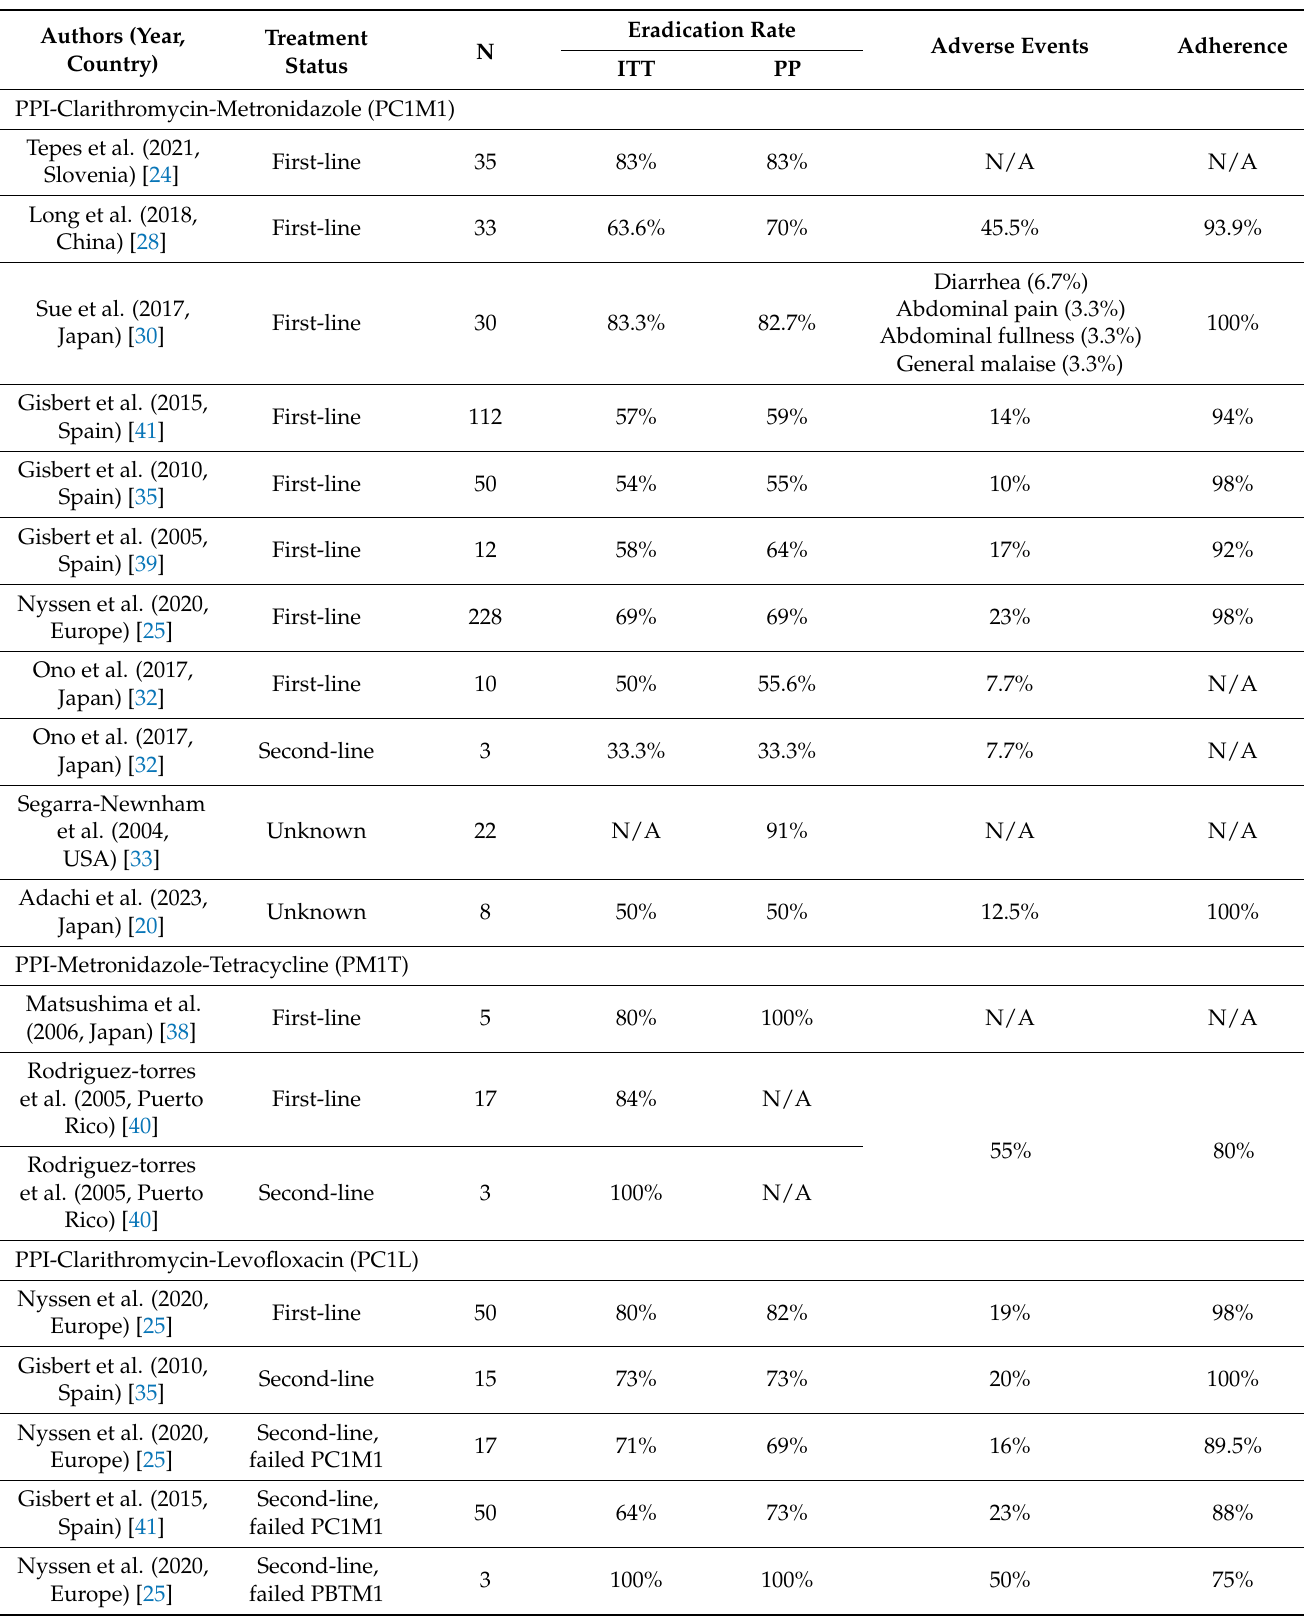
Table 3. Results of PPI-based triple therapy for Helicobacter pylori infection